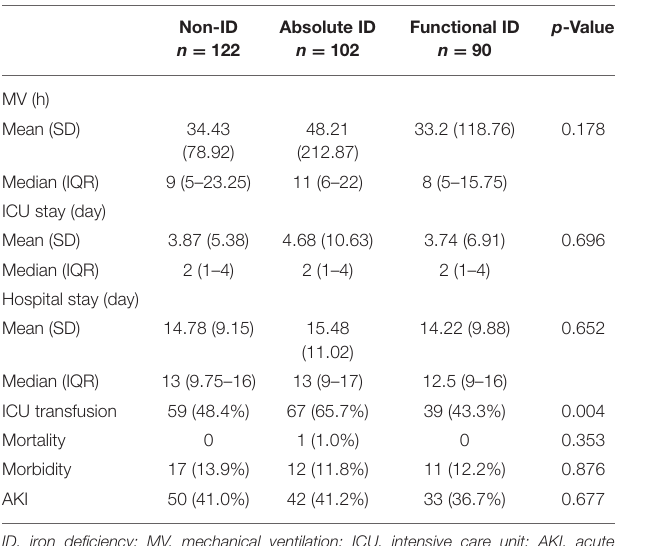
TABLE 6 | Multivariate logistic regression for postoperative RBC transfusion.